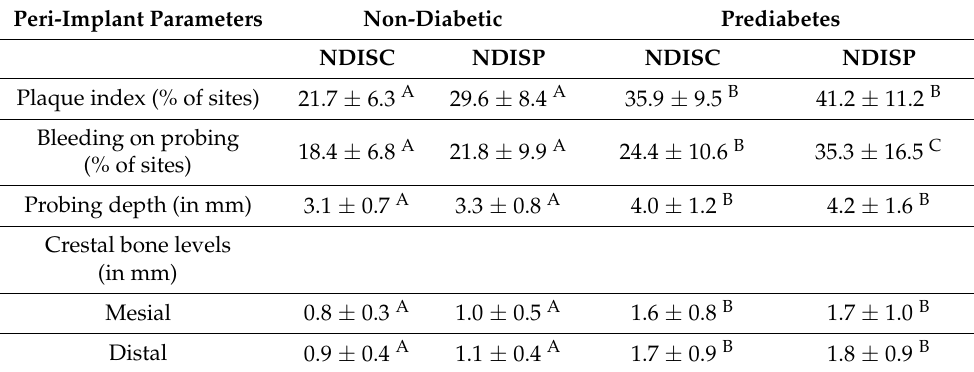
Table 3. Peri-implant soft tissue status among non-diabetic and prediabetic groups and restorations. Peri-Implant Parameters